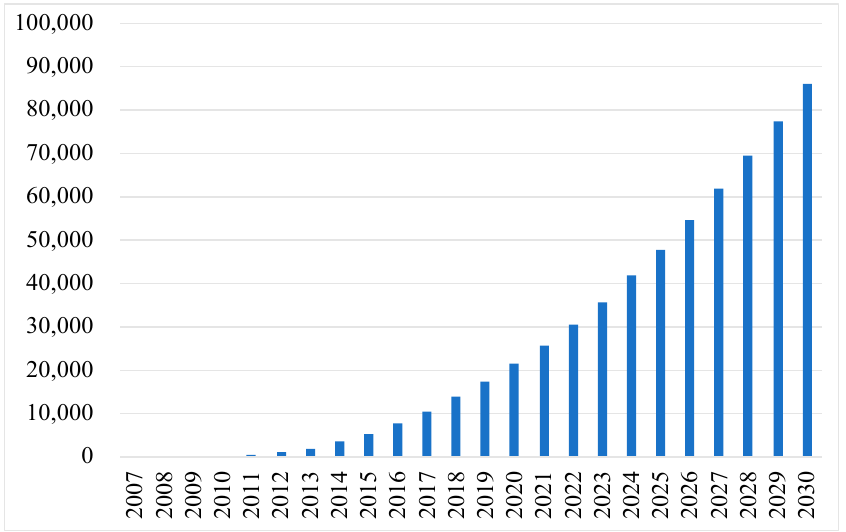
Figure 7. Estimated End-of-Life HV in Mongolia. Source: Figure made by the author based on the information from Automobile Inspection & Registration Information Association; Nippon Steel and Trade Statistic of Japan [7,20,23].